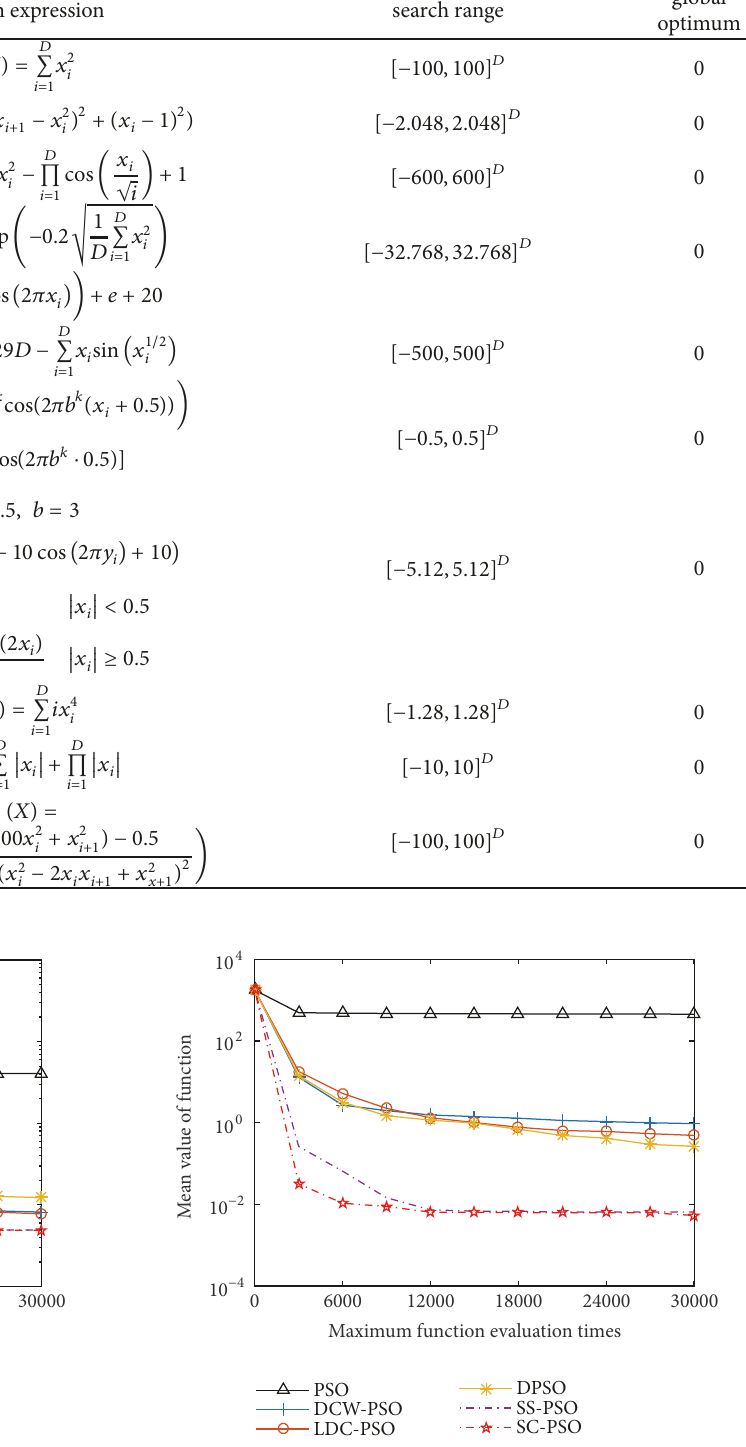
paper is significantly improved while its convergence accu- racy is still guaranteed higher.